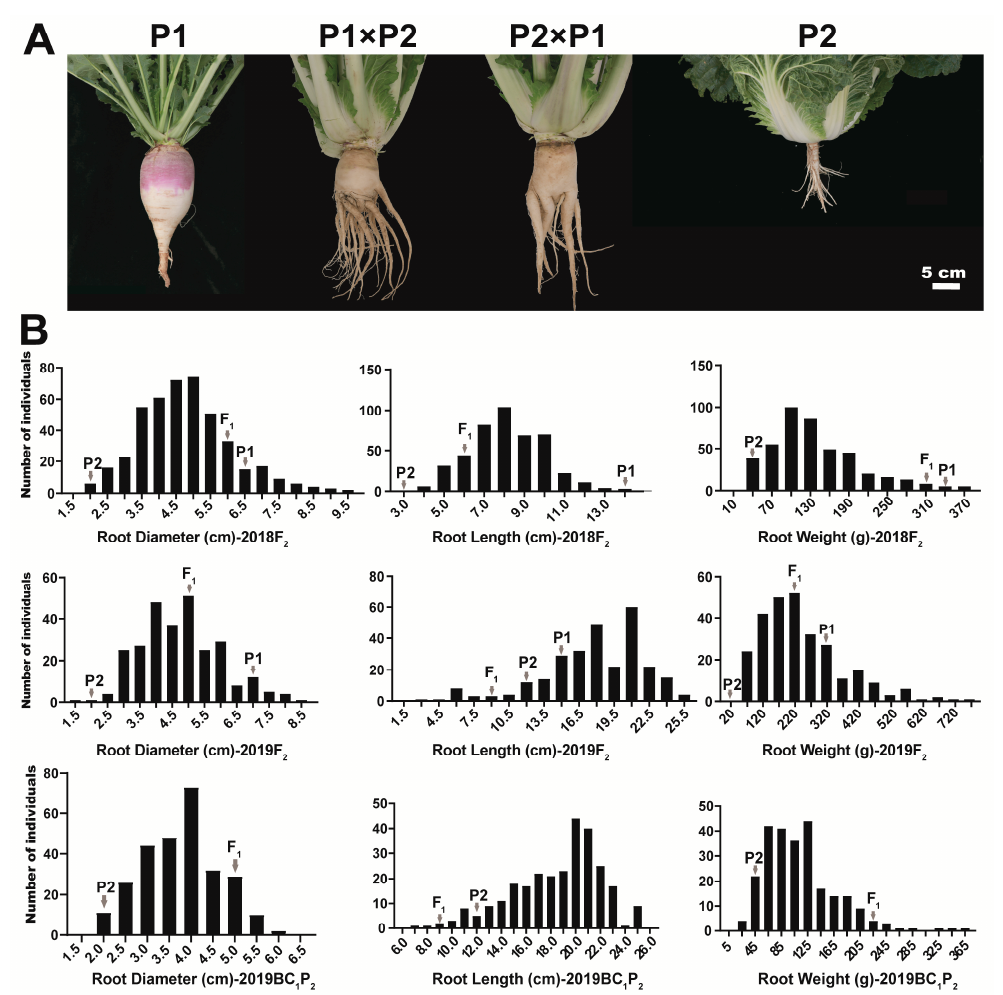
Figure 1. Phenotype of the parents, F 1 , F 2 , and BC 1 P 2 populations. ( A ) Phenotype of P1 (European turnip, Brassica rapa ssp. rapifera ) with swollen root, P2 (Chinese cabbage, Brassica rapa ssp. pekinensis ) with normal root, and two F 1 hybrids, 90 day old plants. Bar, 5 cm; ( B ) Frequency distribution of root diameter, root length, and root weight in F 2 and BC 1 P 2 populations, in 2018 and 2019. Table 1. Statistical analysis of root-related traits in parents, F 1 , F 2 , and BC 1 P 2 populations.